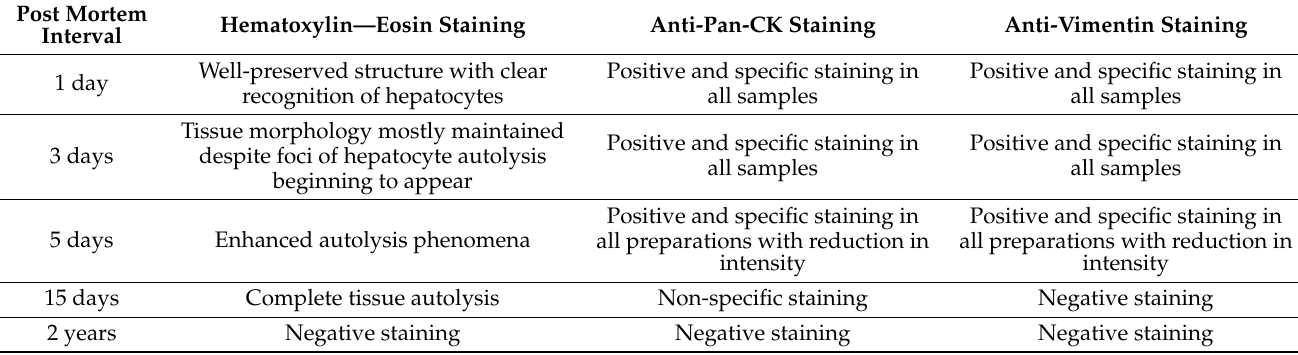
Table 5. Immunohistochemical evaluation of cytokeratin and vimentin in liver